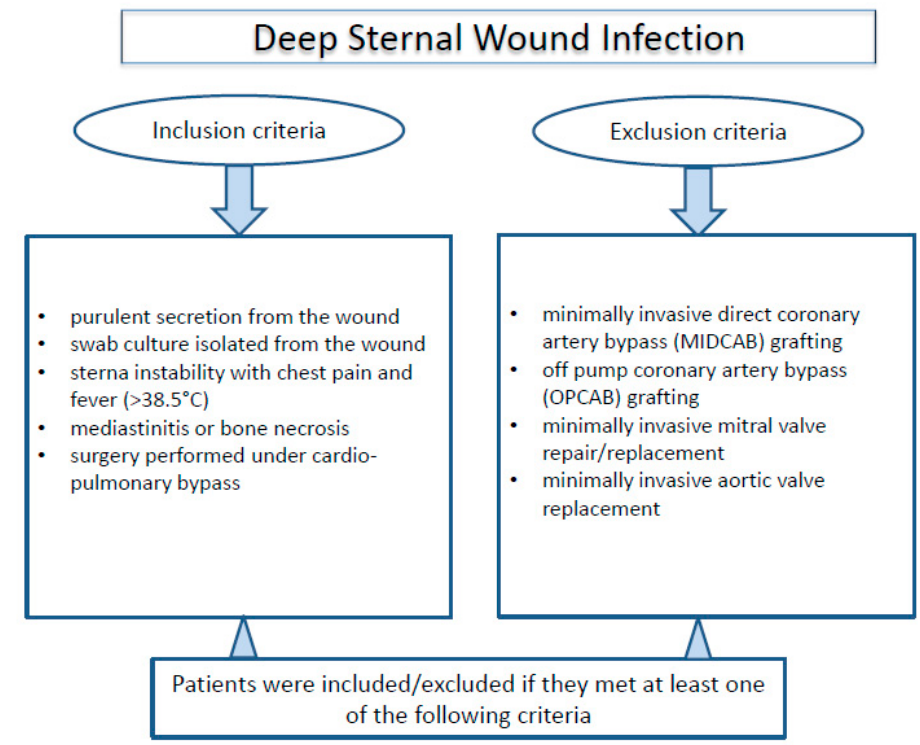
Figure 2. Inclusion and exclusion criteria.